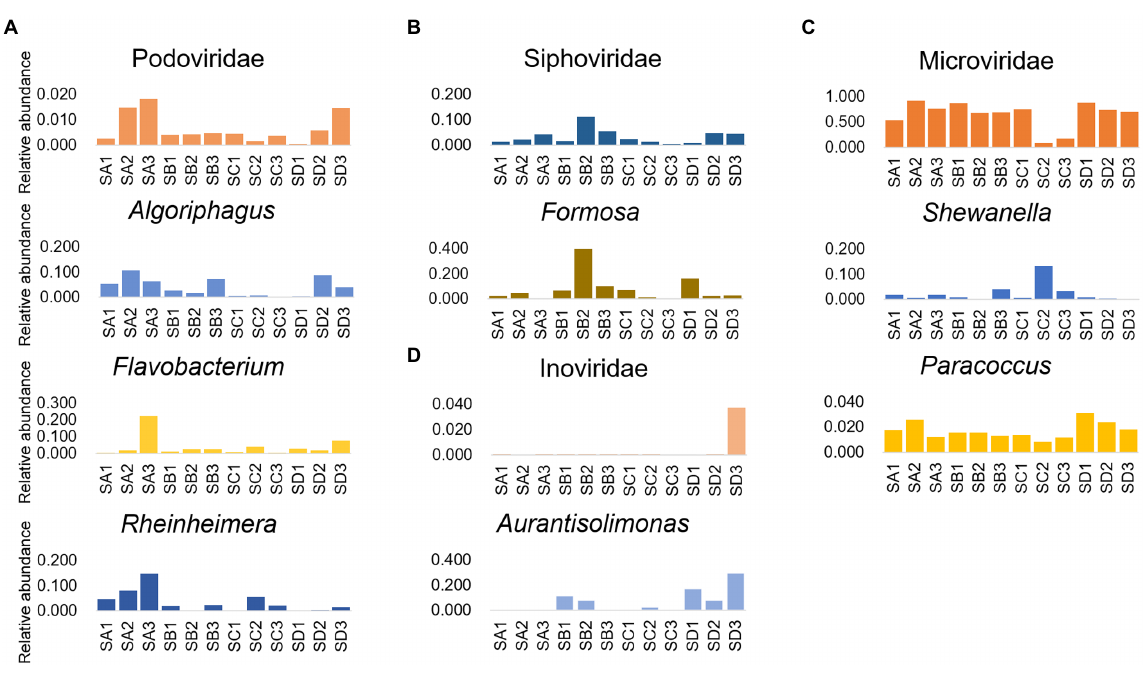
FIGURE 6 Interactional analysis of the phage and prokaryote in sediment. Relative abundance of phage (family level) and prokaryote (genus level) pairs with significant correlation ( p < 0.05), which were dominated in the sediment microbial community, including (A) Podoviridae and Algoriphagus / Flavobacterium / Rheinheimera ; (B) Siphoviridae and Formosa ; (C) Microviridae and Shewanella / Paracoccus ; and (D) Inoviridae and Aurantisolimonas